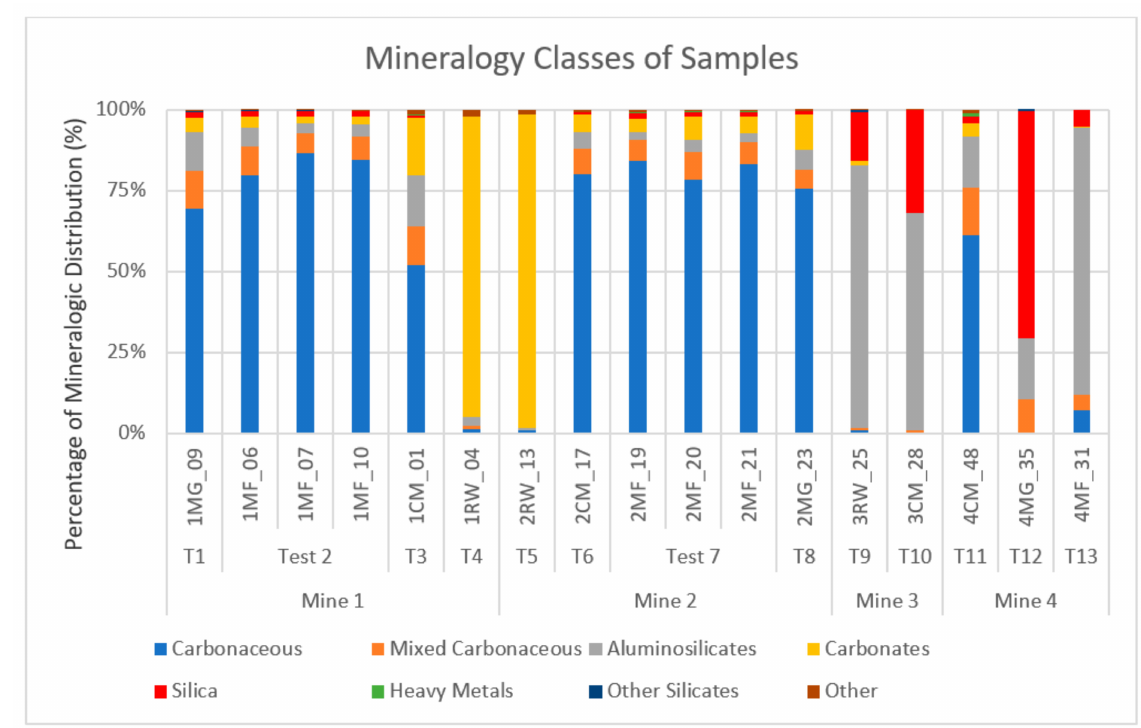
Figure 2. Mineralogy classes of samples for tests 1–13 in mines 1–4. The cumulative particle size for the samples in mines 1 and 2 are shown in (a) and (b) of Figure 3, respectively. The x-axis shows the particle sizes from 1 to 7 microns, while the y-axis displays the cumulative percentage of particles. Lines closer to the top left indicate a finer PSD while those closer to the bottom right indicate a coarser PSD. The continuous miner sample is represented by the dashed line. The longwall maingate samples are represented by the lighter shaded lines with the square markers. The darkest shade denotes the longwall midface samples which were taken in triplicate. The narrow deviation between midface sample lines indicates good agreement between